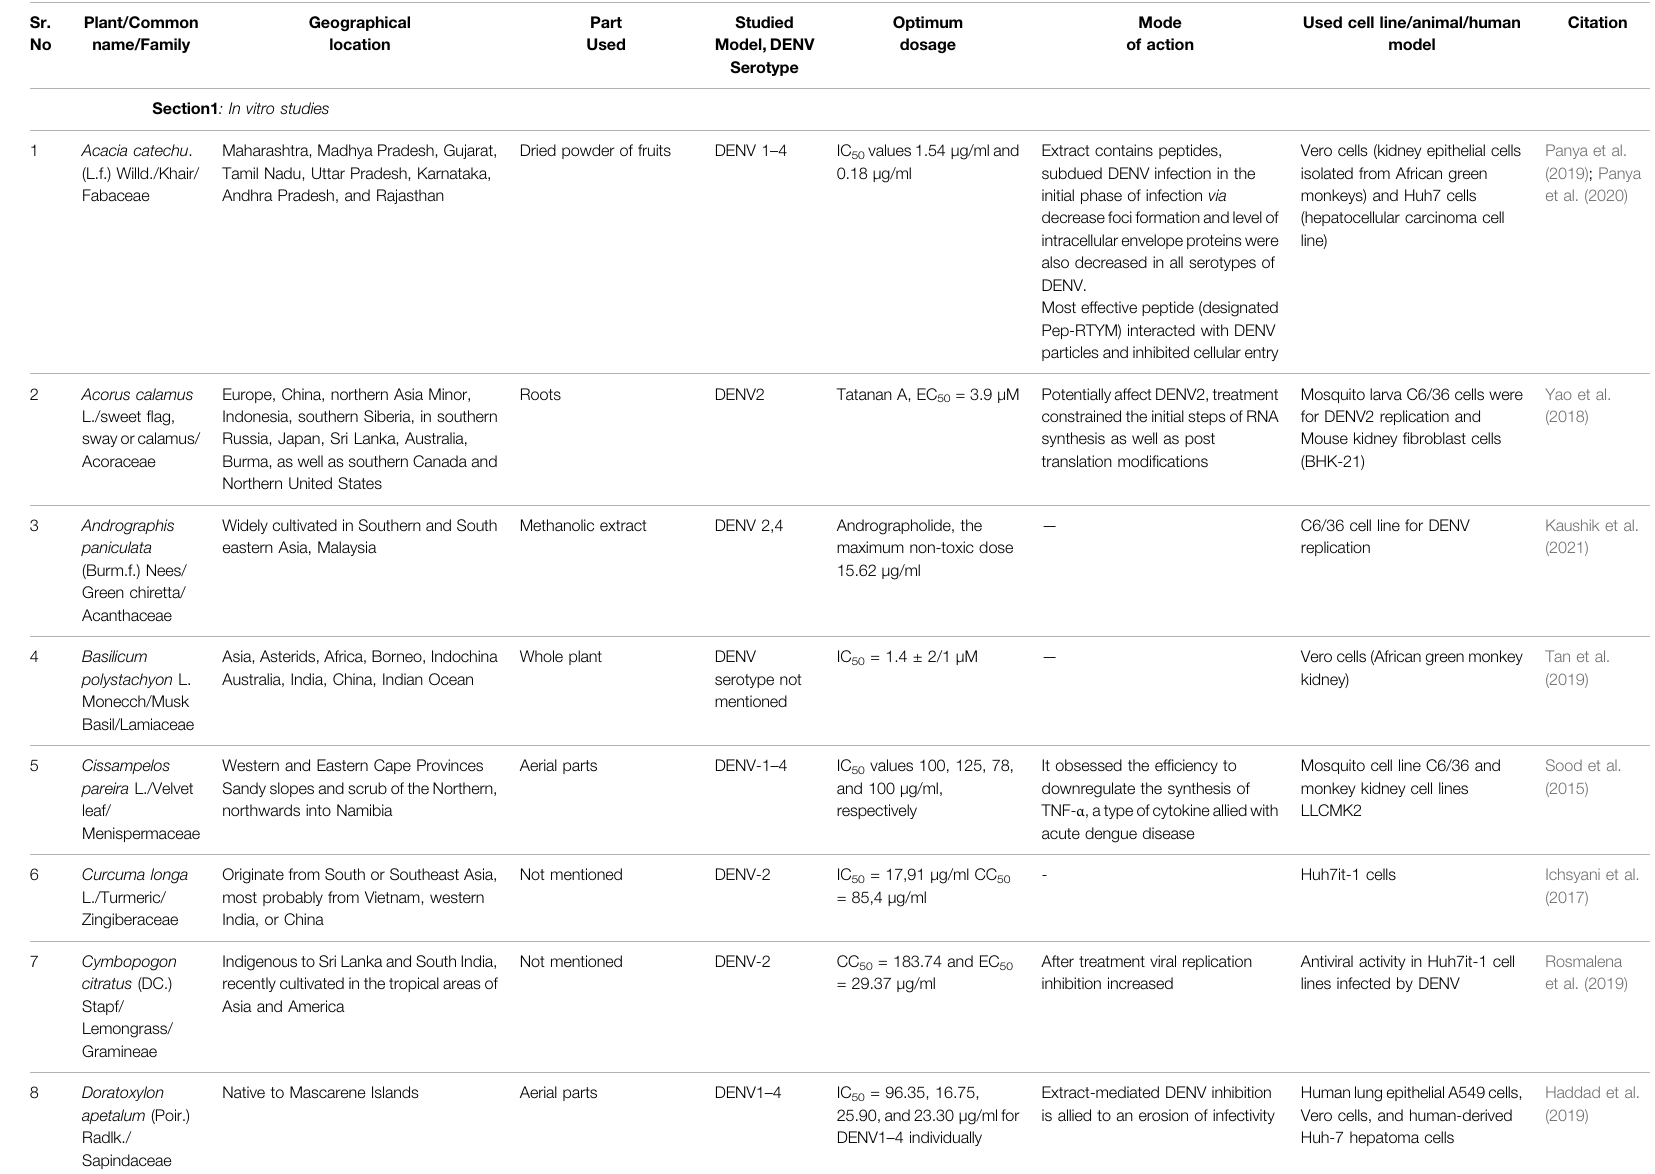
TABLE 2 | List of plants studied for anti-dengue response based on ethnopharmacological use. Sr.